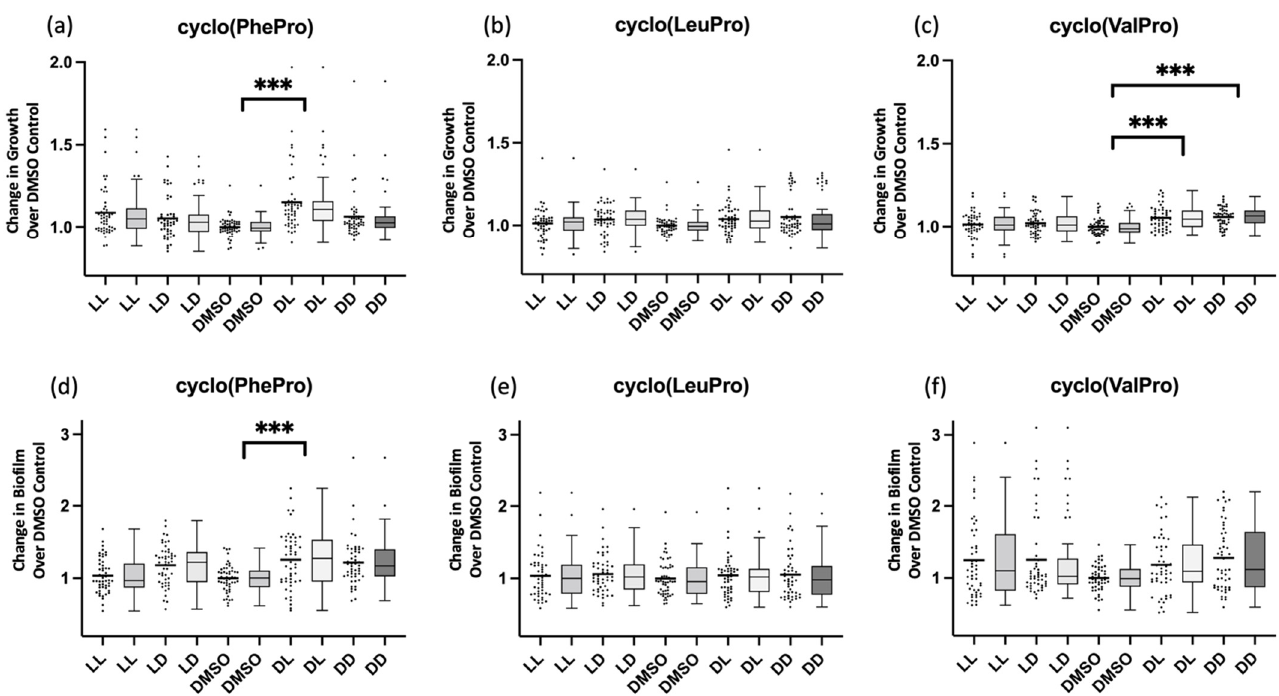
Figure 5. Effects of the synthetic DKP stereoisomers on E. coli growth ( a – c ) and biofilm formation ( d – f ). Both scatter and box-and-whisker plots are presented for each stereoisomer. The effects are normalized by the DMSO control. E. coli cells were treated with the samples (0.1 mg/mL, n = 50) and incubated at 37 °C for 24 h. Overall growth of E. coli was estimated by the OD 600 measurement after incubation. Biofilm formation was determined by the crystal violet assay. The horizontal line in the scatter plot represents the mean, whereas the middle line in the box-and-whisker plot is the median. DMSO: vehicle control. *** p < 0.0001 (t-test).